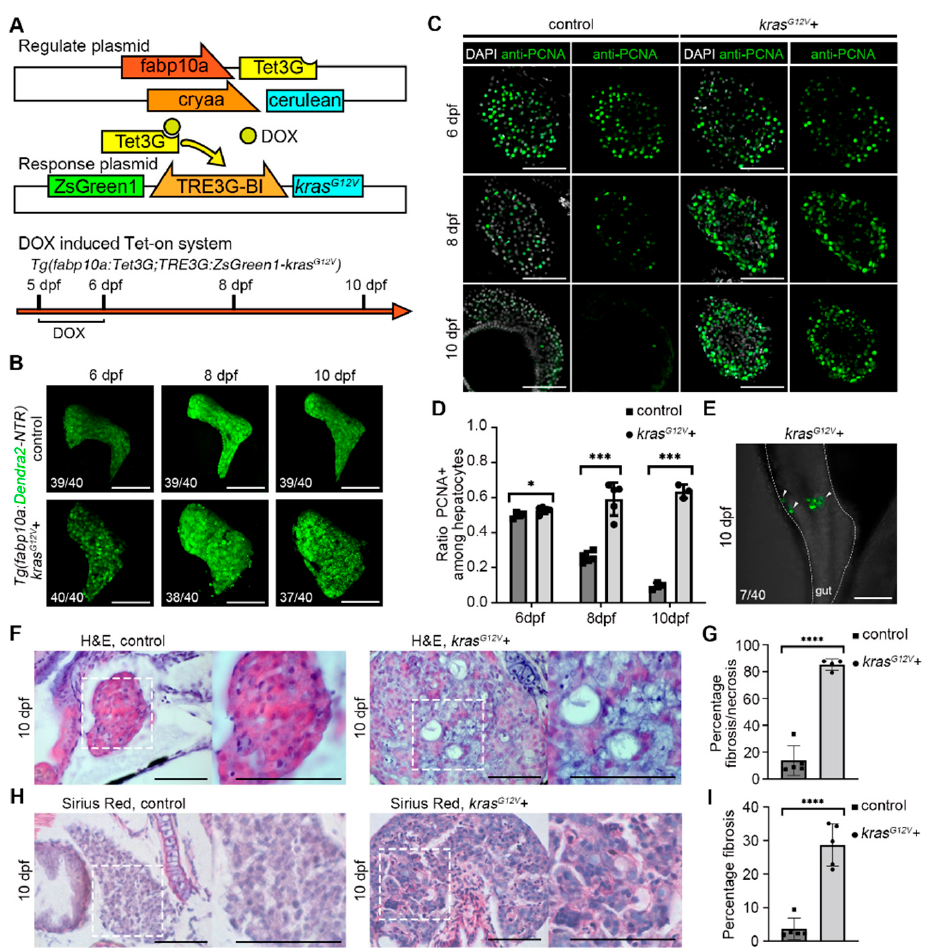
Figure 1. Induction of kras G12V overexpression in zebrafish liver cancer by Tet-On system. ( A ) Components of the Tet-On system and doxycycline (DOX) treatment strategy for induction of liver cancer. ( B ) Confocal images showed zebrafish liver after DOX activation of kras G12V from 6 days postfertilization (dpf) to 10 dpf. ( C , D ) antibody staining results of proliferating cell nuclear antigen (PCNA) in the control group ( n = 11) and kras G12V + group ( n = 13). ( E ) Confocal images showed the presence of a green, fluorescent signal in the intestine outside the liver after DOX activa- tion of kras G12V . ( F ) H&E staining to confirm the morphology of the liver in the control and kras G12V + groups. ( G ) Statistics of the percentage fibrosis/necrosis area in the liver in the control ( n = 5) and kras G12V + ( n = 4) groups. ( H ) Sirius Red staining of the liver in the control and kras G12V + groups. ( I ) Statistics of the percentage fibrosis area in the liver in the control ( n = 5) and kras G12V + ( n = 5) groups. Numbers indicate the percentage of larvae exhibiting this expression. Asterisks show significance: *— p < 0.05; ***— p < 0.001; ****— p < 0.0001. Scale bars—100 µ m; error